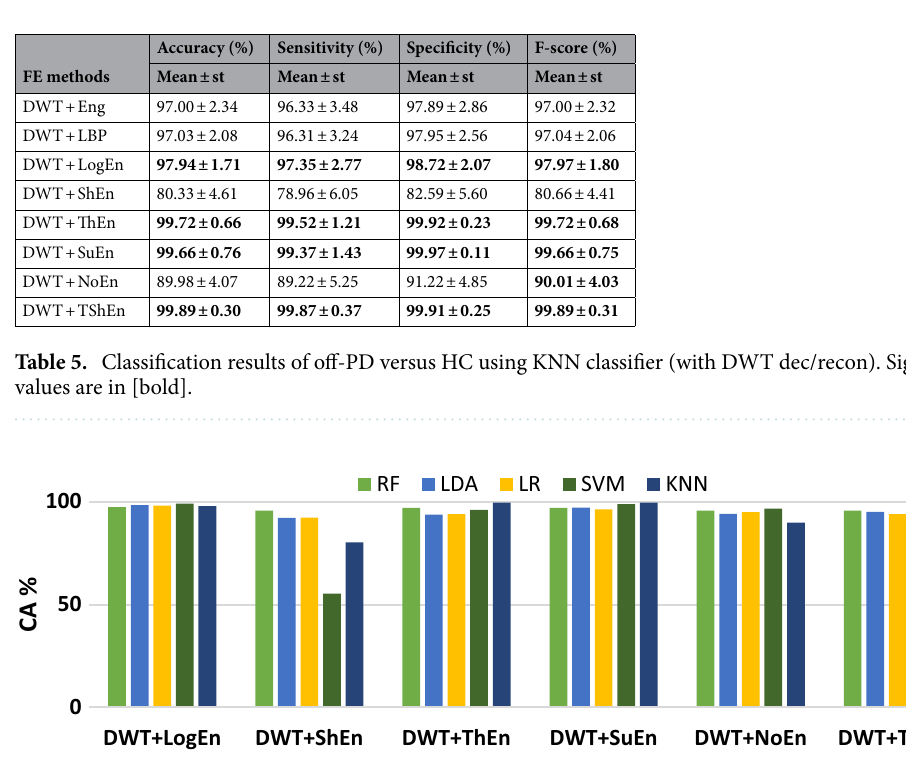
Figure 5. Average classification accuracy (off-PD vs. HC) using RF, LDA, LR, SVM, and